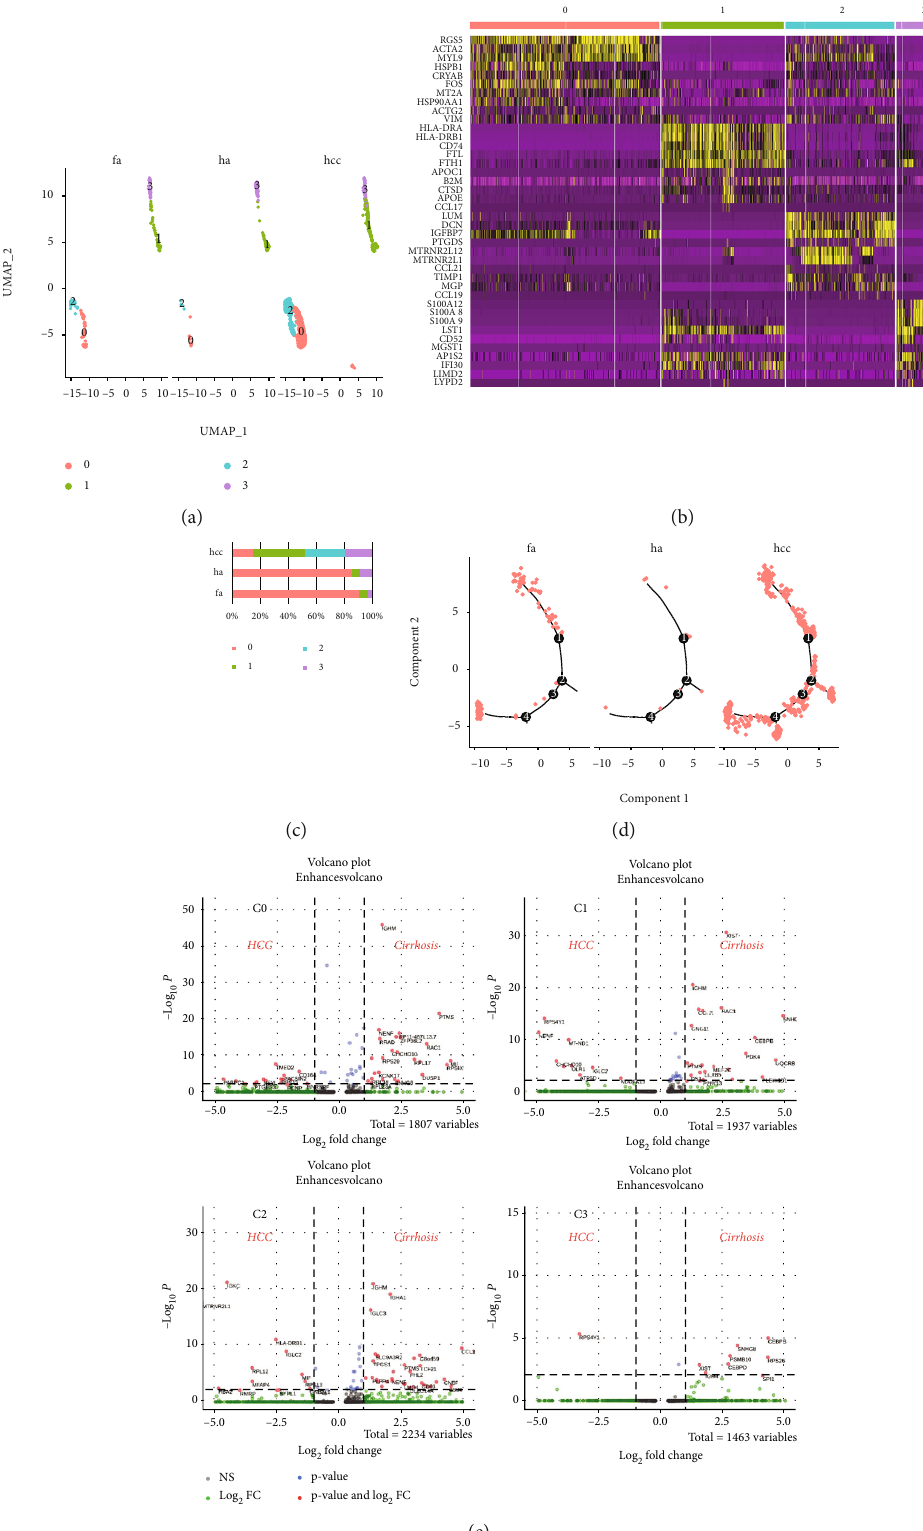
Figure 4: Subcluster analysis of the macrophages and the stroma cells. (a) UMAP diagram depicts the subclustering of macrophages and stroma cells. (b) Heat map annotated the di ff erent genes of the subcluster cell types. (c) Bar graphs quantify and compare the proportion of subclusters of healthy, fi brosis, and HCC patients. (d) Analysis of the trajectory of cluster 0 in the healthy, fi brosis, and HCC state. (e) Volcano plots show the DEGs between fi brosis and HCC in 4